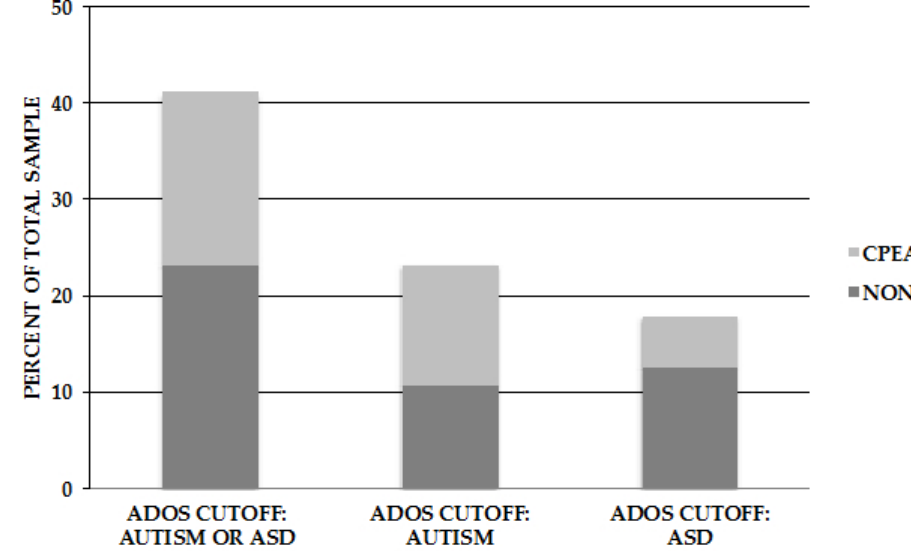
Figure 3. Figure 3 shows the percentages of individuals meeting the Autism Diagnostic Observational Schedule (ADOS) cutoff criteria. Within each cutoff category, diagnostic groups are designated as those who either met the Collaborative Programs of Excellence in Autism (CPEA) criteria for an ASD diagnosis (CPEA-ASD), or those who did not meet these criteria (non-ASD).